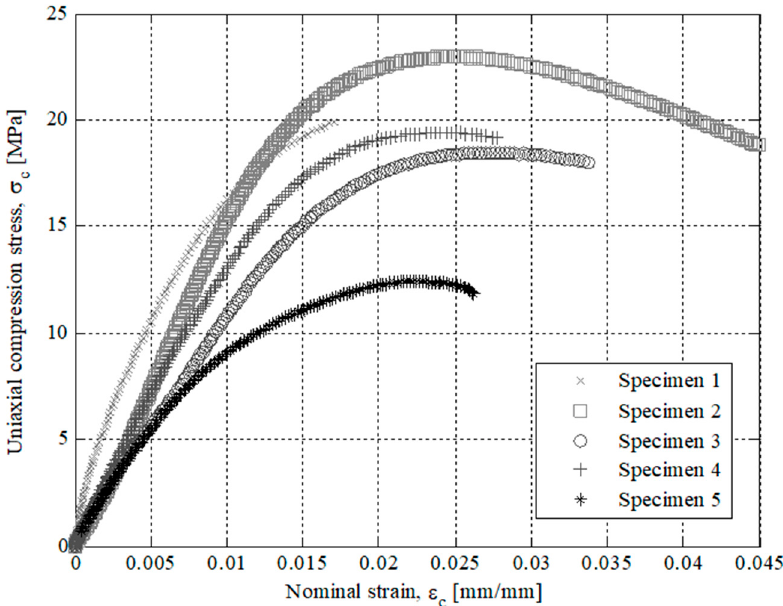
Figure 10. Curves for X-Axis manufactured specimens related to uniaxial compression stress versus nominal strains.